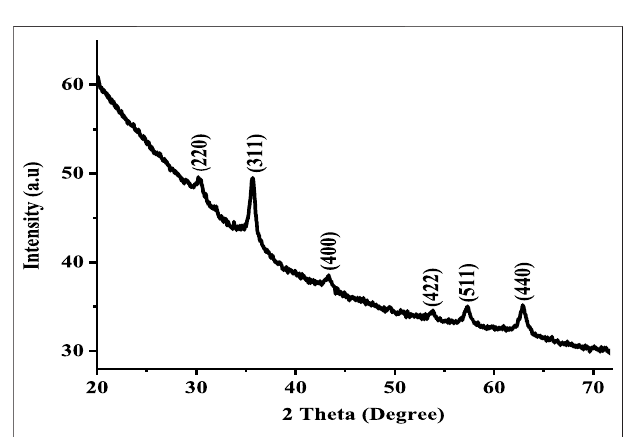
FIGURE 1 | X-ray diffractogram of Fe 3 O 4